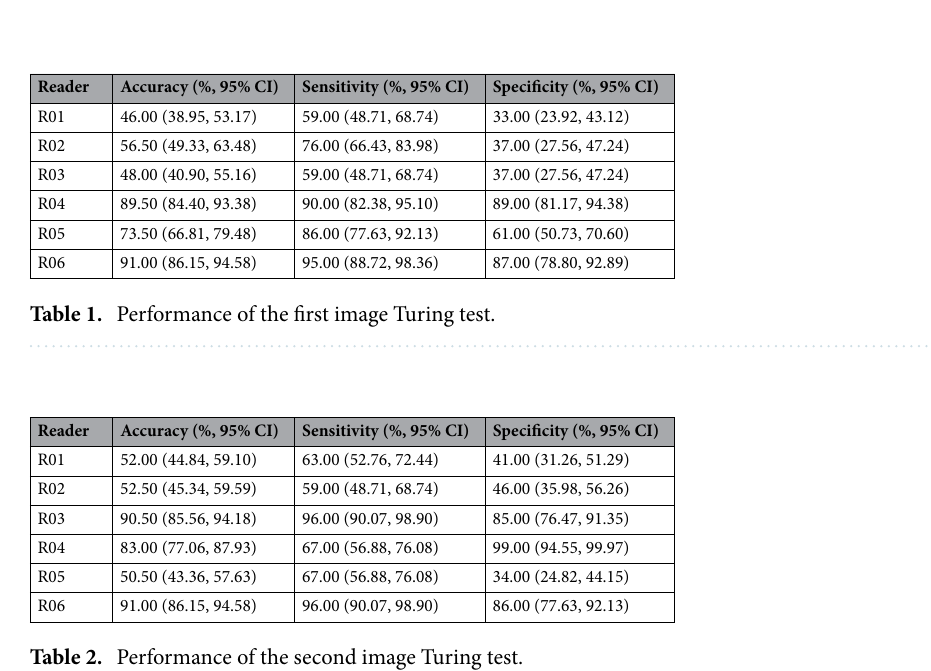
Table 2. Performance of the second image Turing